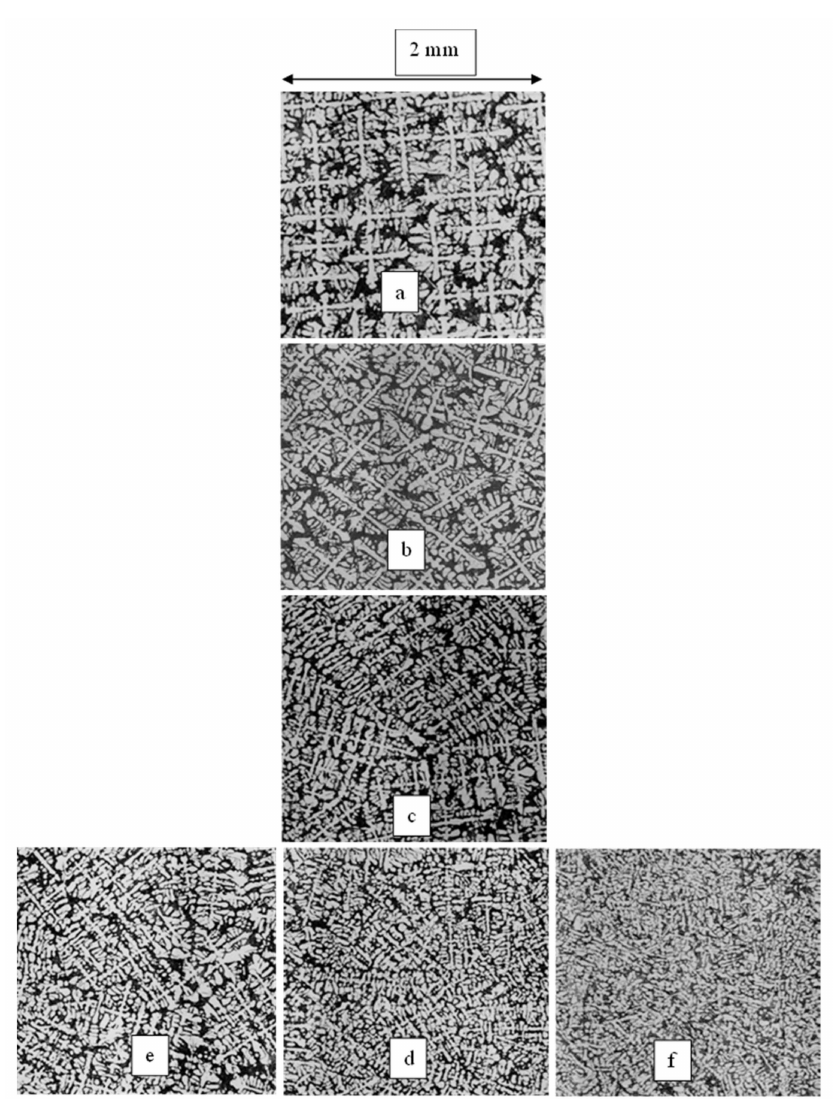
Figure 18. Dendritic structure of unidirectional solidification of the Al–7%Si–1%Fe alloy. Etching with 2 V% HF water solution. Temperature gradient (G): 5 K/mm, solid/liquid front velocity (v): 0.05 mm/s. ( a ) B = 0 mT, ( b ) B = 40 mT, “x” type, ( c ) B = 40 mT, “y type”, ( d ) B= 40 mT, “xy” type, ( e ) B = 20 mT, “xy” type, and ( f ) B = 80 mT, “xy” type. The grain structure of the samples changes with the type of magnetic field and the value of the magnetic induction (Figure 19). The magnetic induction in the case of